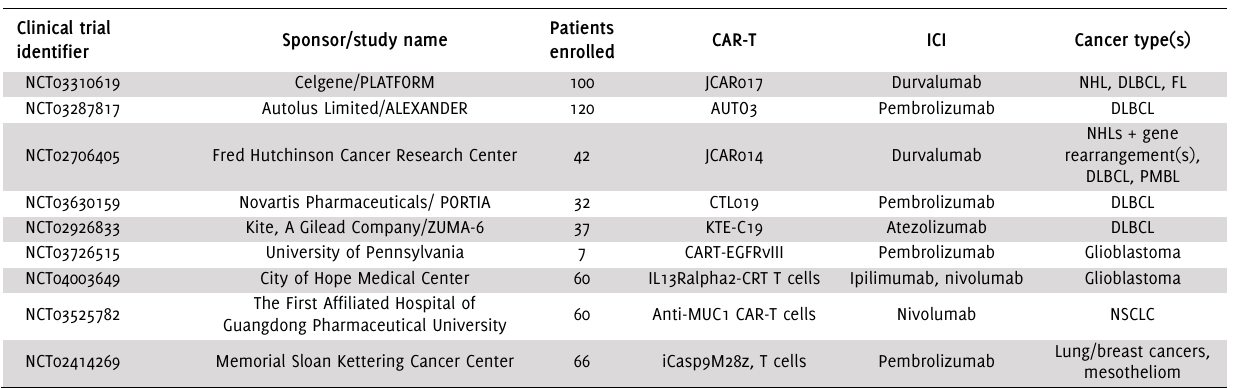
Table 2 . Clinical Trials Evaluating CAR-T Cell Combination Therapy With PD-1 Blockade Clinical trial